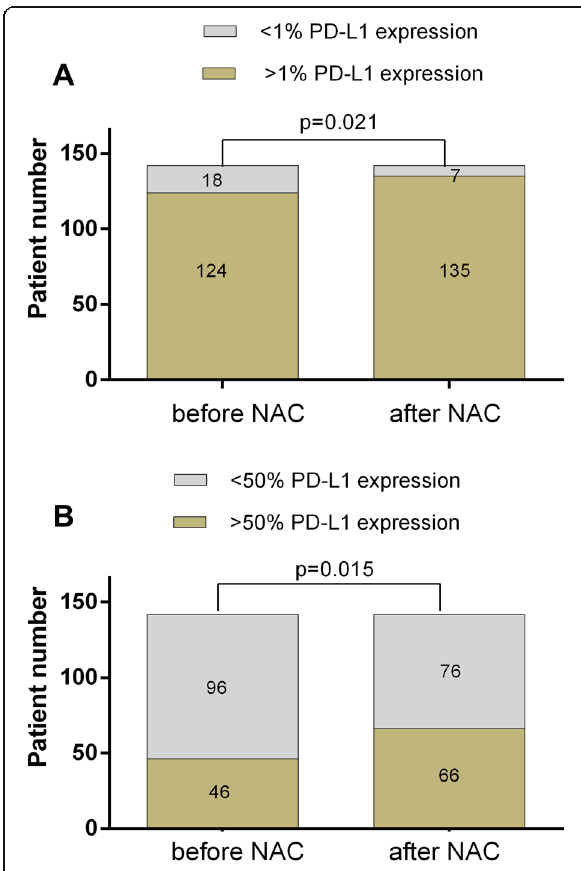
Fig. 2 Distribution of PD-L1 expression before and after NAC. More patients had PD-L1 expression with a threshold > 1% (A) and > 50% (B) after